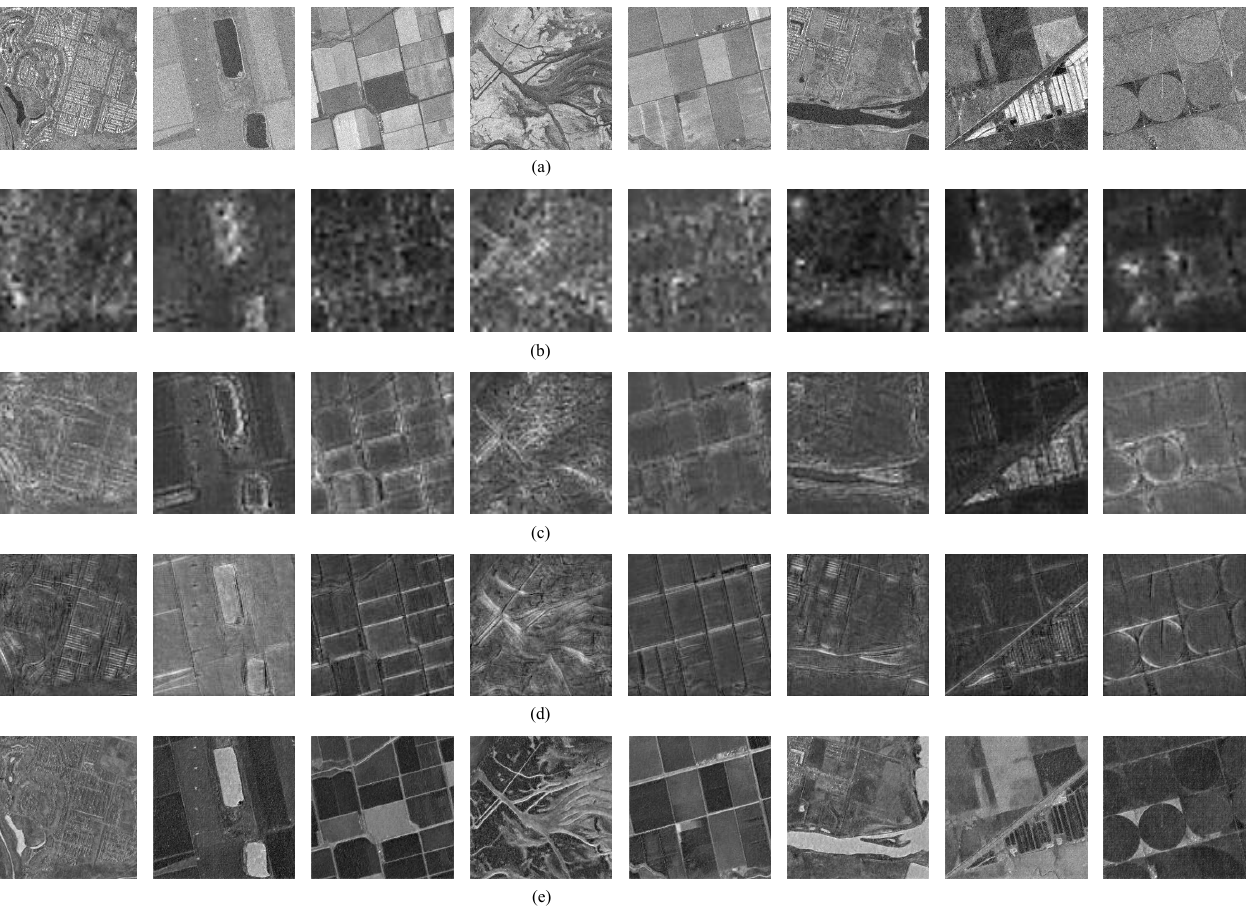
Figure 14. Visualization features of SSAM1-SSAM4. ( a ) Original SAR images. ( b – e ) The visualization features of